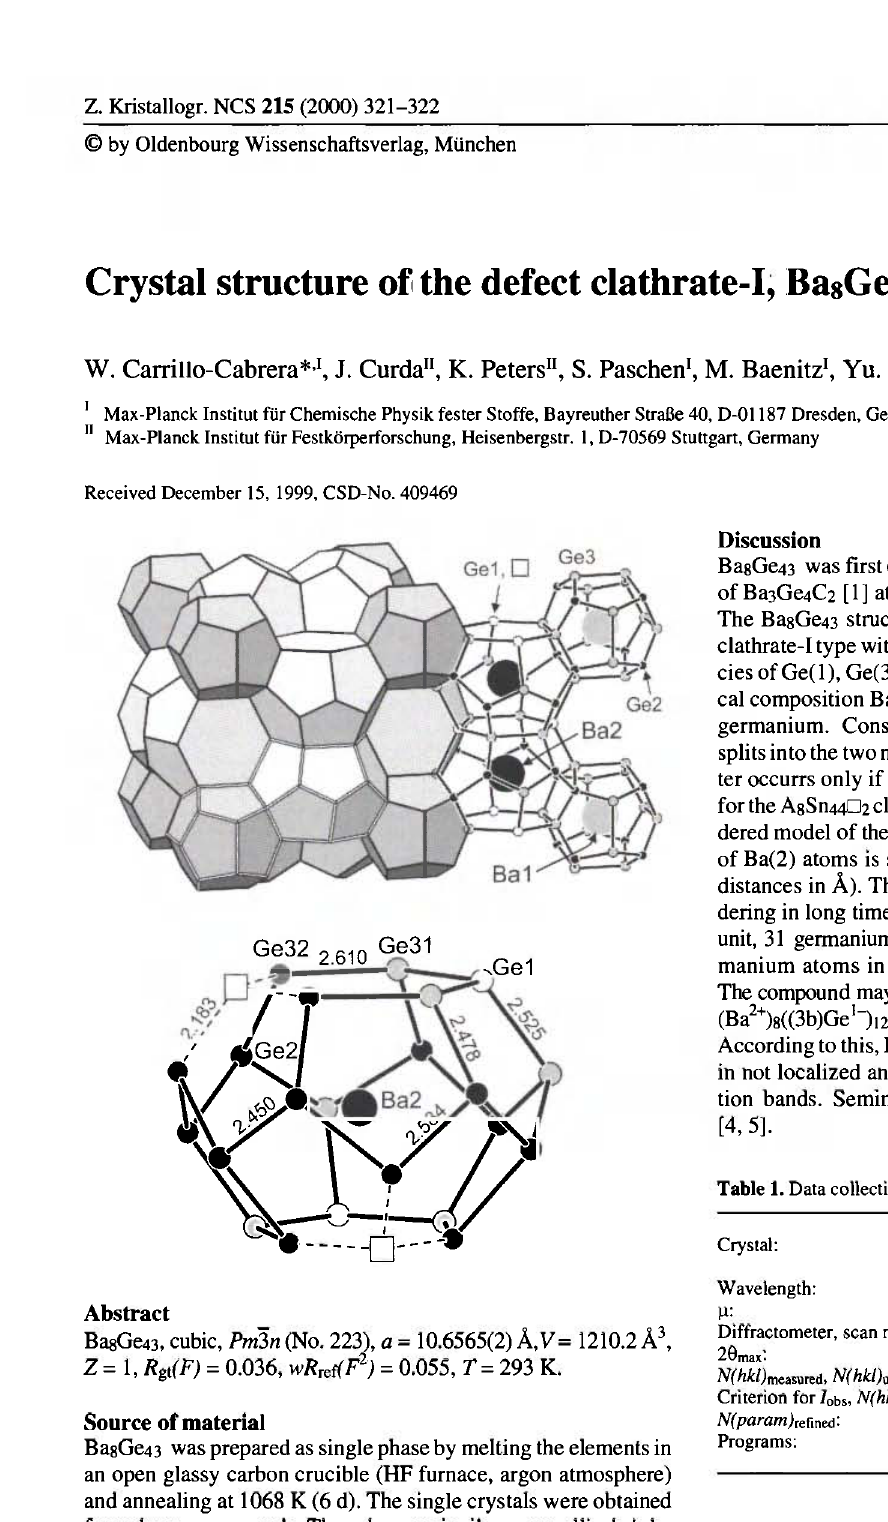
Table 2. Atomic coordinates and displacement parameters (in Ä 2